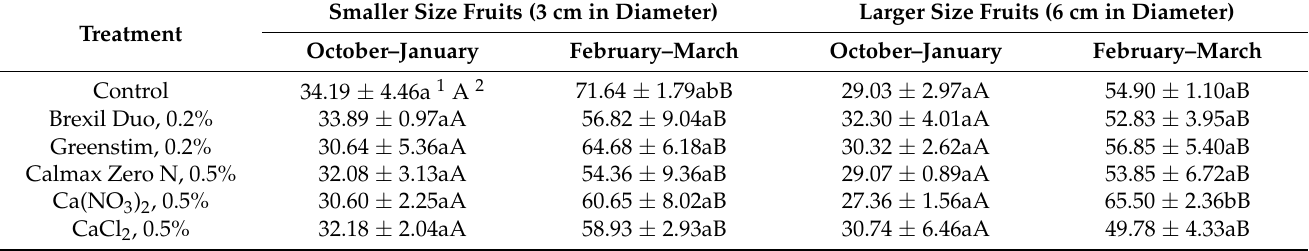
Table 7. The effect of spraying different Ca-containing/Ca uptake-promoting preparations on the mean (K + Mg)/Ca ratio of ‘Beorange’ tomato fruits in two periods of the production cycle: